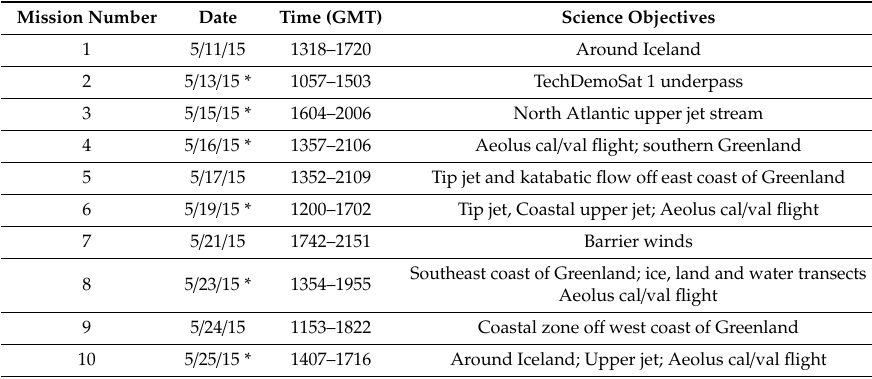
Figure 1. Mission flight paths for PW1 ( left ) and PW2 ( right ) (Google Earth). Table 2. Mission flights and science objectives during PW2.